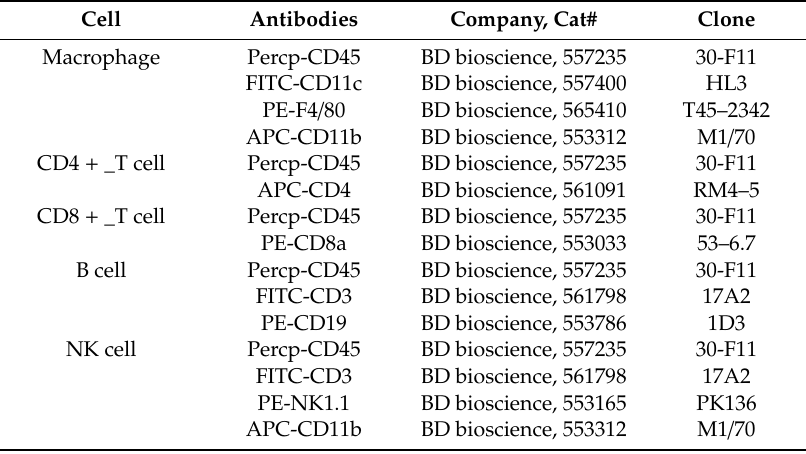
Table 2. Cell surface markers used for the flow cytometric